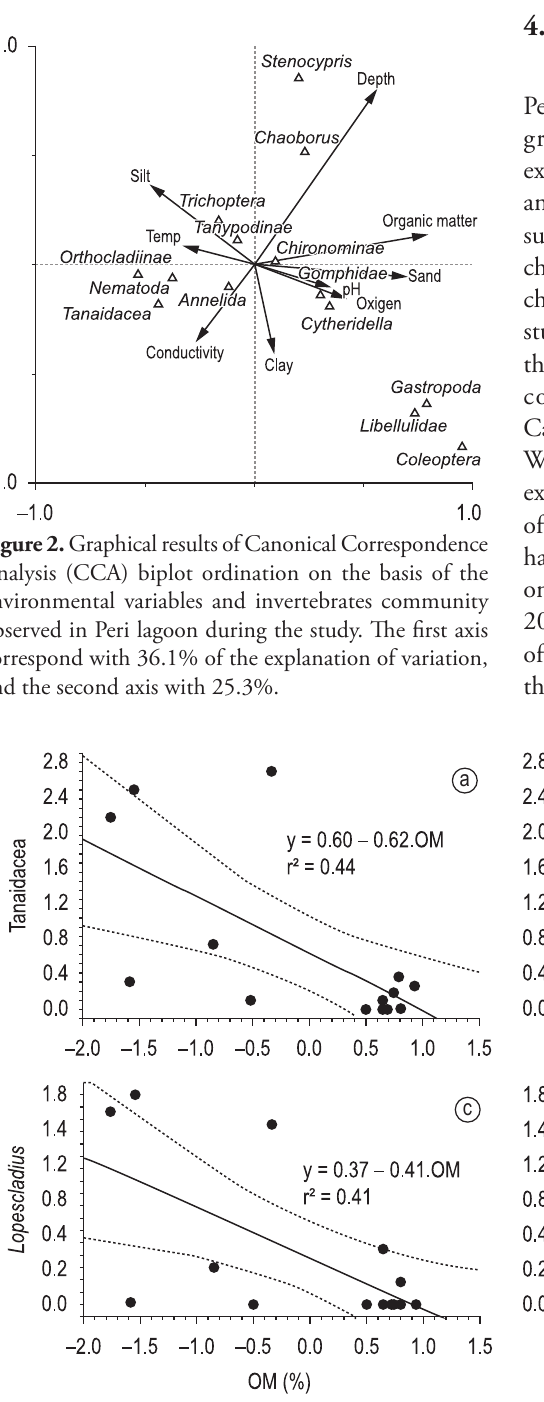
Figure 3. Responses of Tanaidacea to OM (a) and sand (b), and Lopescladius to OM (c) and sand (d) with regres- sions fit equations and r 2 values. It was considered the mean density (225 cm –2 ) of the taxa log (n+1) transformed, and abiotic variables log (x) transformed. Dashed lines represents 95% confidence interval. Straight fits in all cases are significant (p <